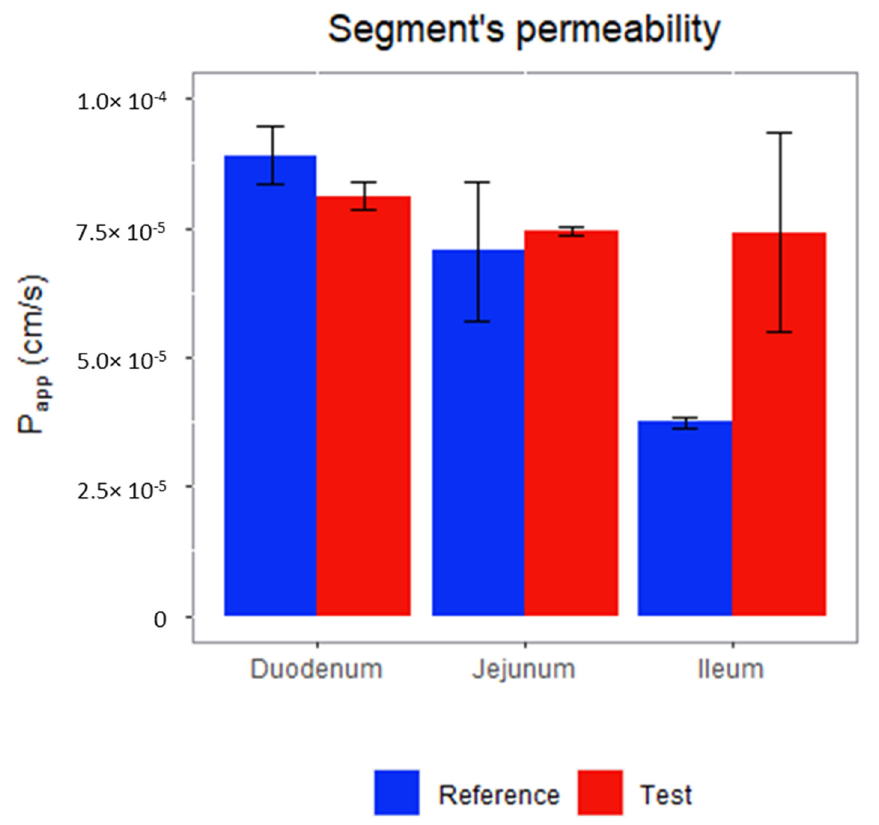
Figure 5. Final product permeability in duodenum, jejunum, and ileum.